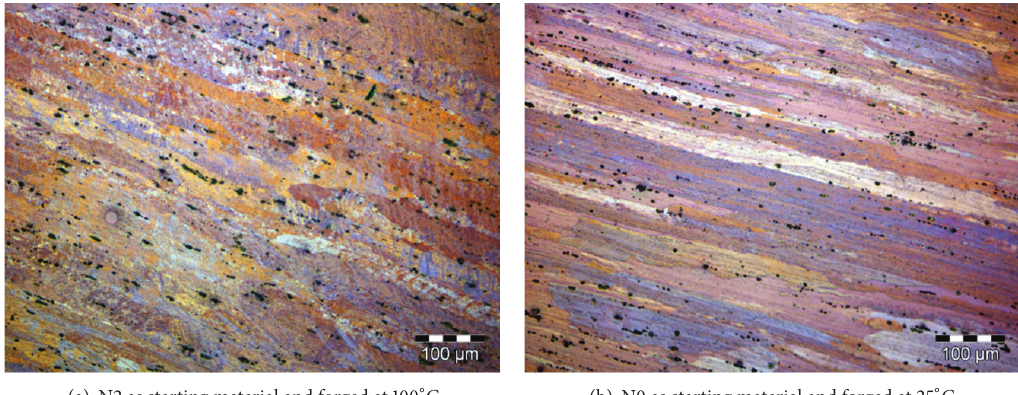
Figure 6: Optical micrographs at 200x of zone 6 of the blades.